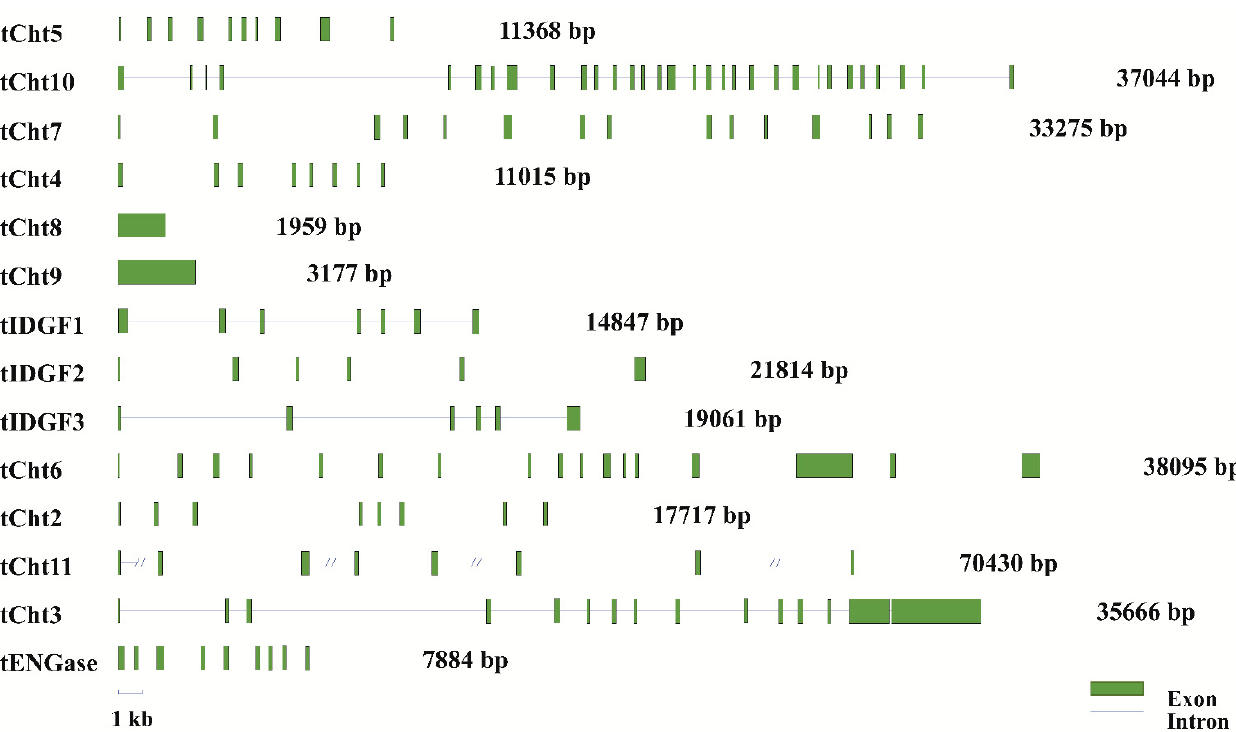
red. CR, conserved region.